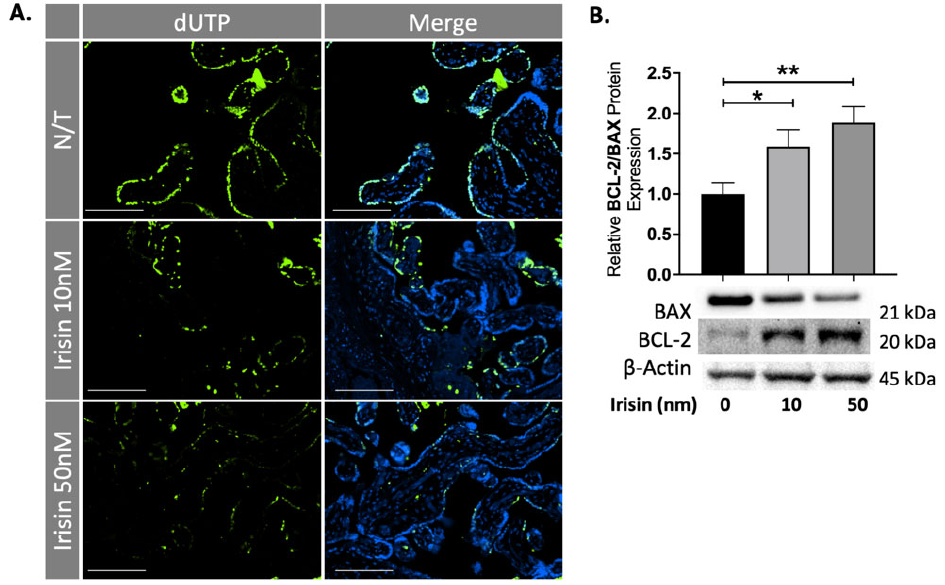
Figure 1. Irisin reduces apoptosis in the preeclamptic placenta. ( A ) A TUNEL assay shows a significant reduction of double-stranded DNA breaks, as measured by dUTP fluorescent molecules, when treated with Irisin. ( B ) 10 nm and 50 nm Irisin treatment in the preeclamptic placenta increased the anti-apoptotic BCL-2: pro-apoptotic BAX protein levels (n = 8). (Relative protein expression was determined by normalization to β -actin, a one-way analysis of variance and subsequent Tukey’s post hoc test to analyze differences between cohorts; * p < 0.05, ** p < 0.01. Bar plots are presented as mean ± SEM. Scale bar = 100 µ m. Green staining indicates DNA strand breaks; Blue staining is for Dapi indicating the cell nucleus. dUTP, deoxyUridine TriPhosphate; PE, Preeclampsia).